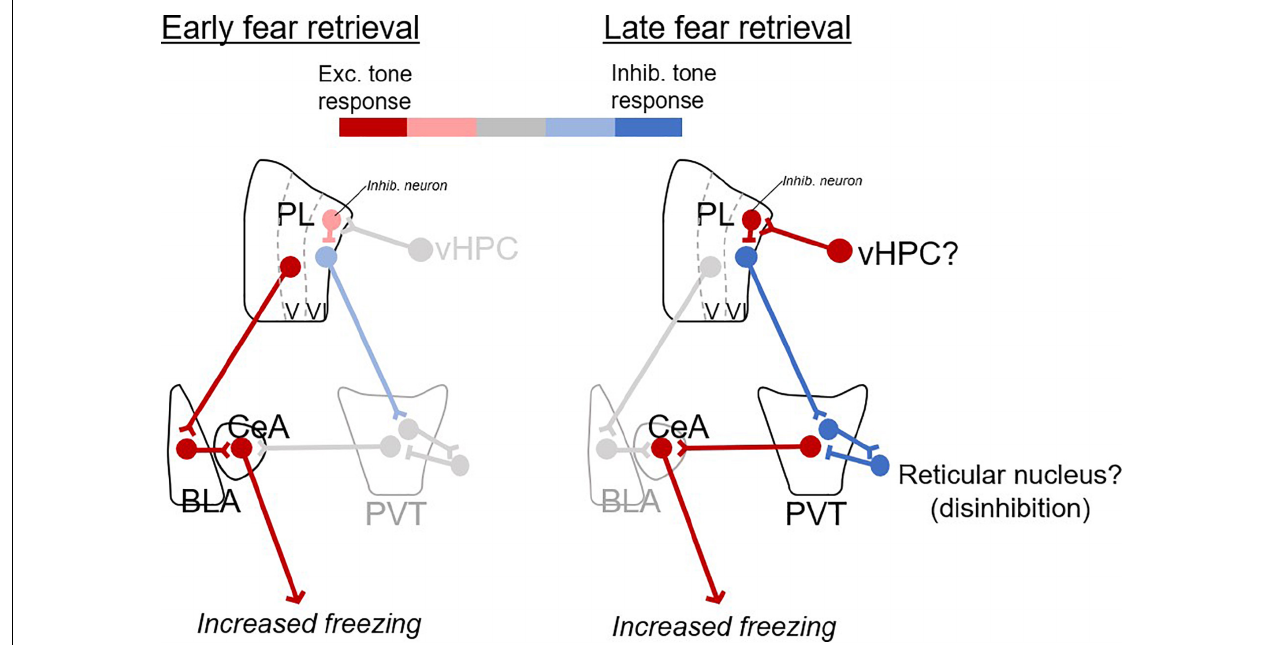
FIGURE 4 | Proposed model of prelimbic circuits for early and late fear retrieval. Changes in excitatory (red) and inhibitory (blue) responses with the passage of time. For early retrieval (left) , excitatory CS responses from PL to BLA excite CeA output to produce freezing. For late retrieval (right) , inhibitory CS responses from PL to PVT disinhibit PVT (via neurons in the reticular nucleus of thalamus), which excites CeA and produces freezing. The ventral hippocampus (vHPC) is suggested as a likely candidate for inducing inhibitory CS responses in PL